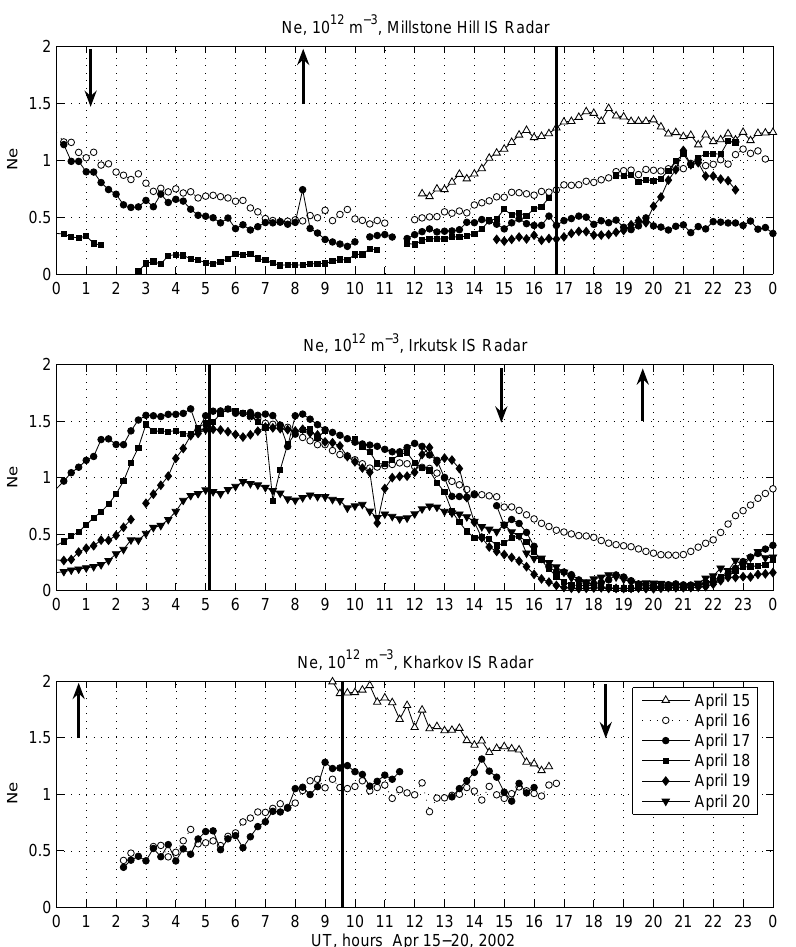
Fig. 9. Electron density measured at ∼ 350km by Millstone Hill ISR (top), Irkutsk ISR (middle), and Kharkov ISR (bottom). Vertical lines show local noon for each location, while arrows indicate sunrise (up) and sunset (down) times at 350km